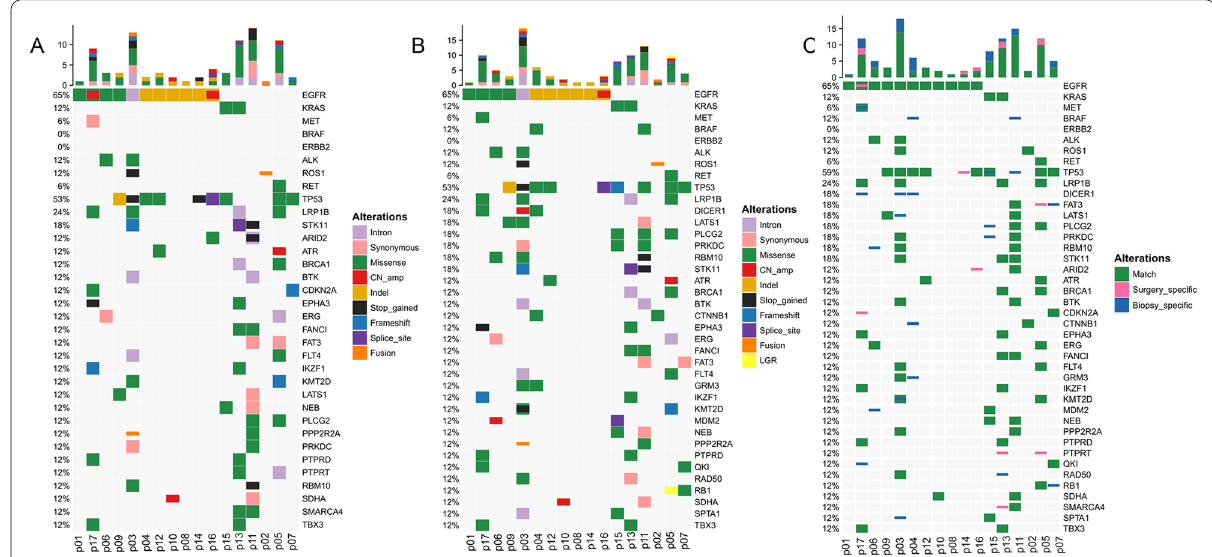
Fig. 3 Mutational landscape and concordance analysis. A Genetic profiles of the surgical resection specimen; B Genetic profiles of the CNB specimen; C The comparison of genetic profiles of resection specimen and matched CNB sample. Green indicates mutations detected from both sources, pink indicates mutations that were present only in the surgical resection specimens, and blue indicates mutations that were present only in the core needle biopsy samples. CNB: core needle biopsy specimens; CN_amp: copy number amplification; InDel: small insertion and deletion;